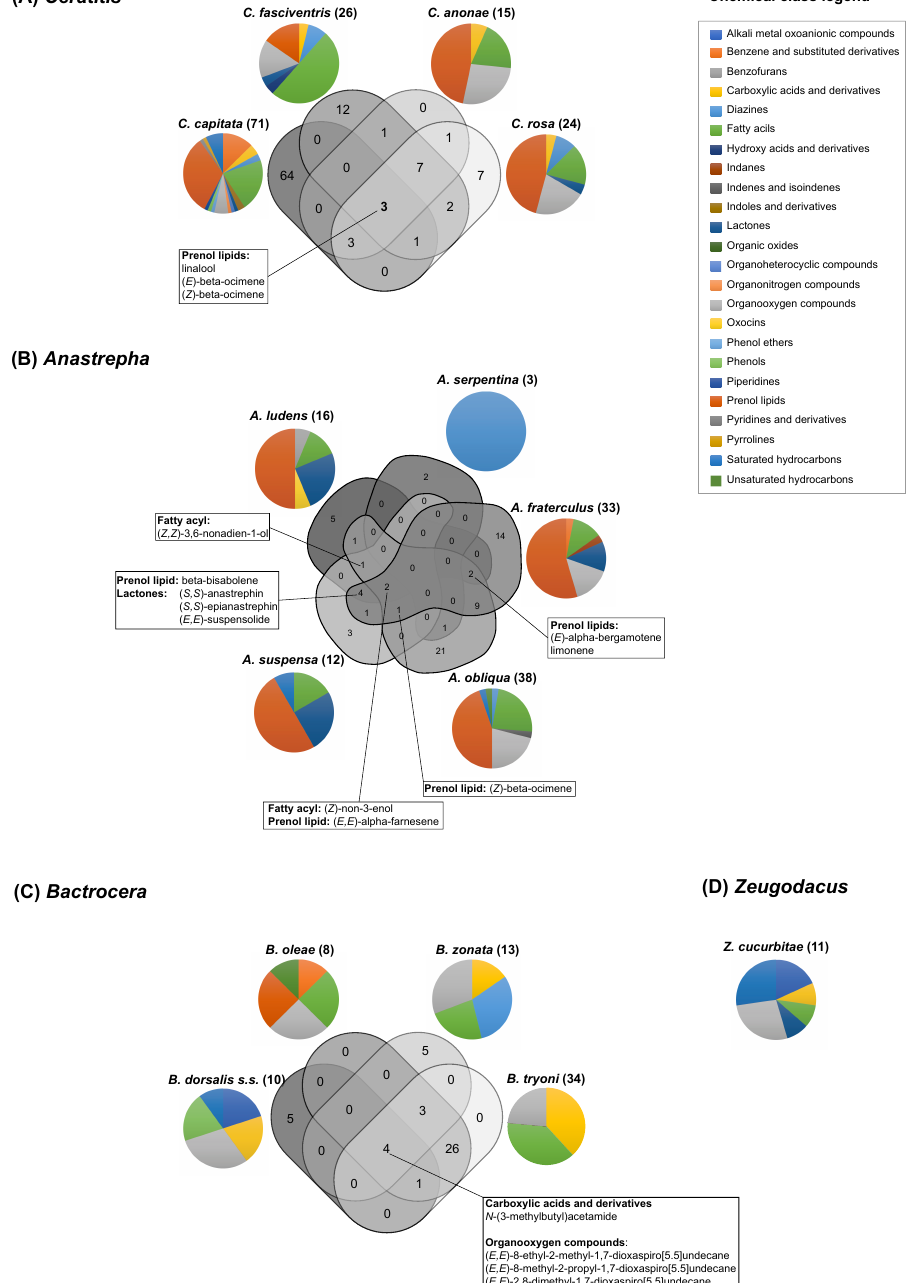
Figure 4. Overlap among chemicals identified in the headspace emissions of tephritids. Venn diagrams (http:// bioinformatics.psb.ugent.be/webtools/Venn/) (accessed on 10 March 2021) illustrating the number of common and unique chemicals found among the compared species in the ( A ) Ceratitis , ( B ) Anastrepha , and ( C ) Bactrocera genera. ( D ) For the genus Zeugodacus , the number of compounds emitted by Z. cucurbitae are reported. Pie charts represent the proportion in chemical classes of the total number of compounds (in parenthesis) isolated for each